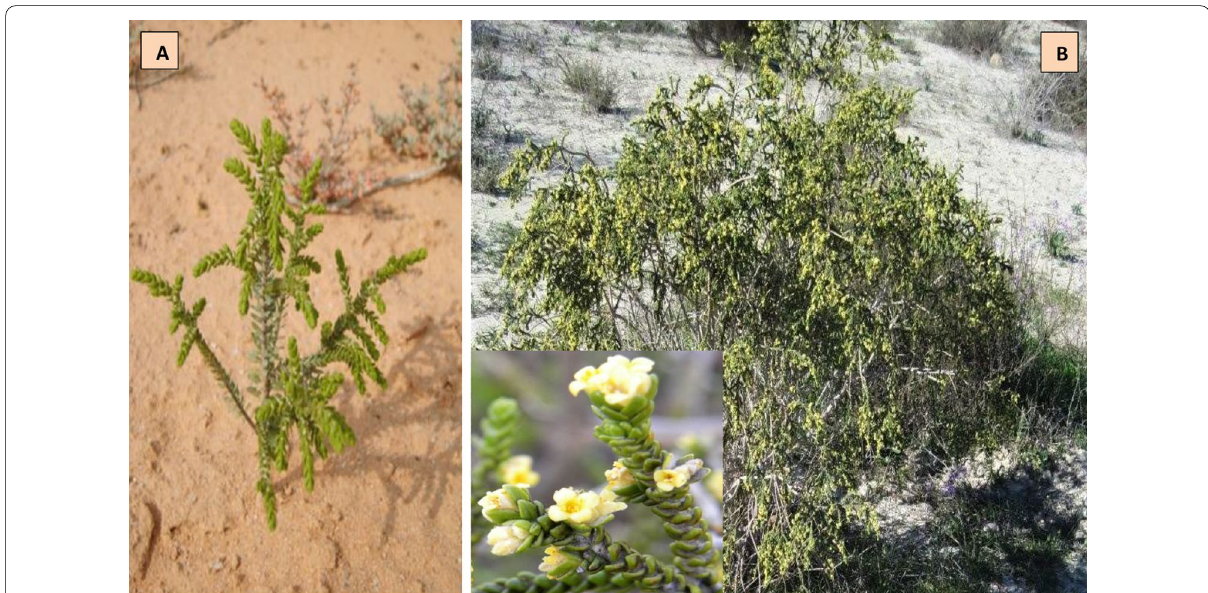
Fig. 1 Thymelaea hirsuta (L.) (Thymelaeceae), A: a young plant on the inland depression, at El Omayed site; B: a mature plant at blooming stage on the coastal ridge at El Gharbaniat